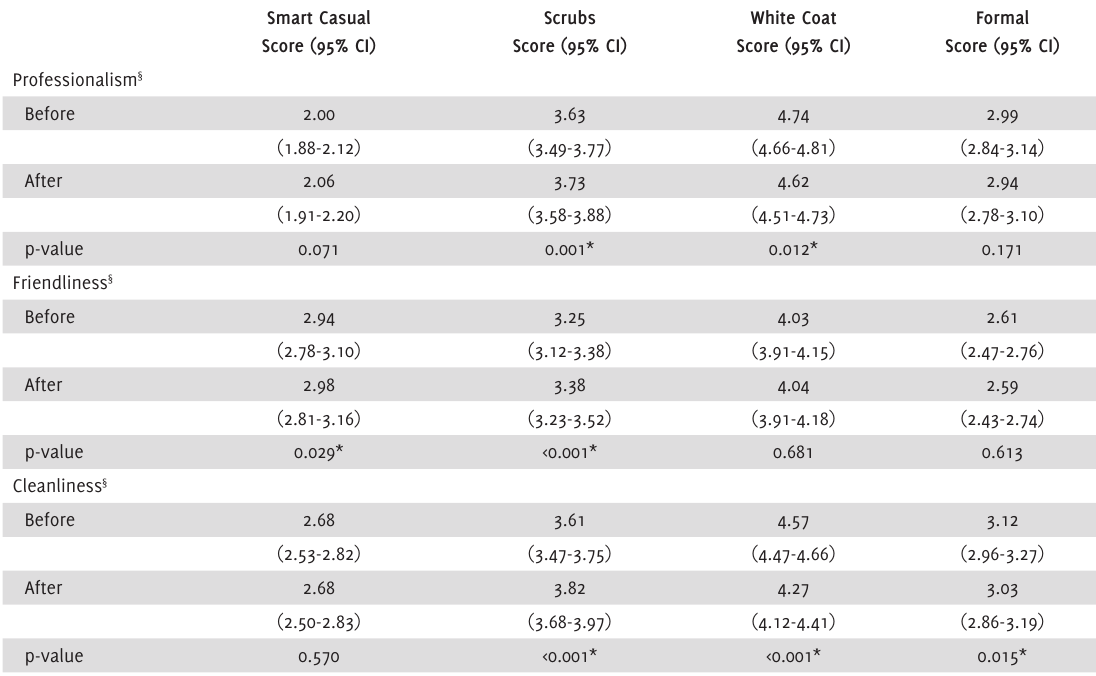
Table 2. Patient’s Perception of Professionalism, Friendliness and Cleanliness by Type of Doctor’s Attire Before and After the Disclosure of the Potential Risk for Microbial Contamination